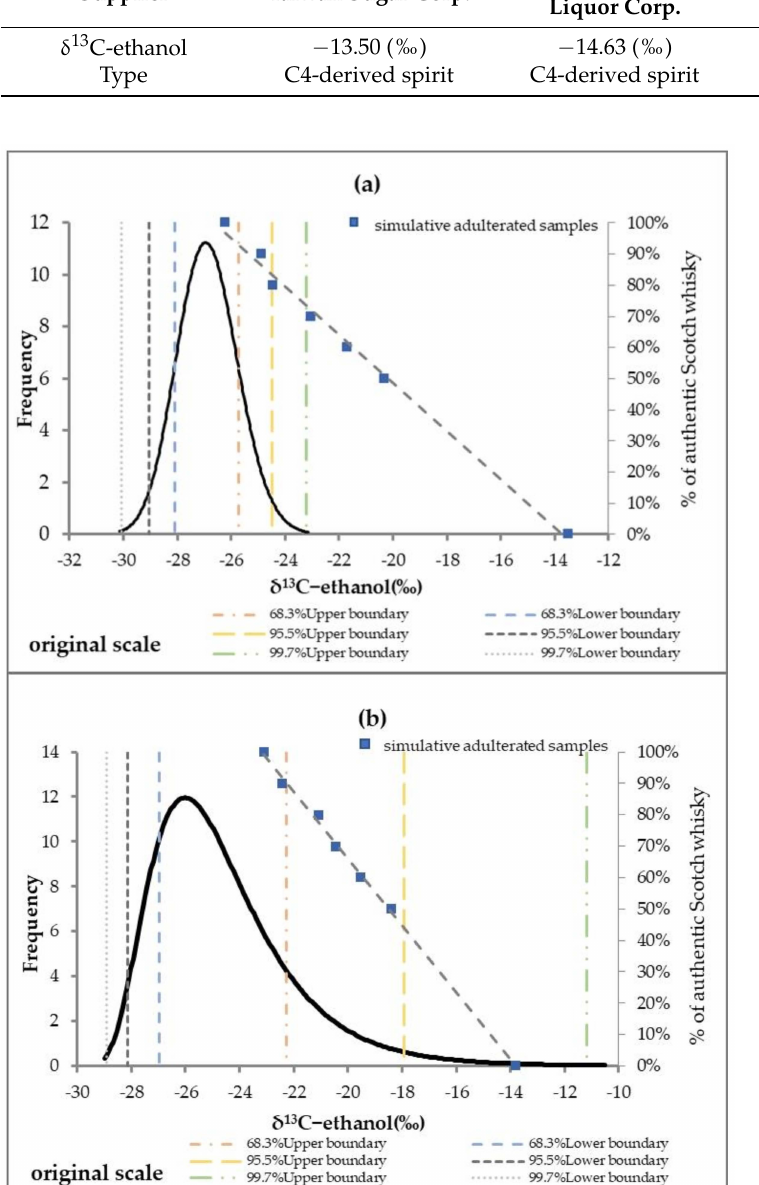
Figure 4. The relation between the percentage of authentic Scotch whisky and the observed δ 13 C- ethanol after adding various amounts of rectified spirit with a δ 13 C − ethanol of − 13.50‰(avg.) to ( a ) an authentic single malt Scotch whisky with a δ 13 C − ethanol of − 26.21‰(avg.) and ( b )